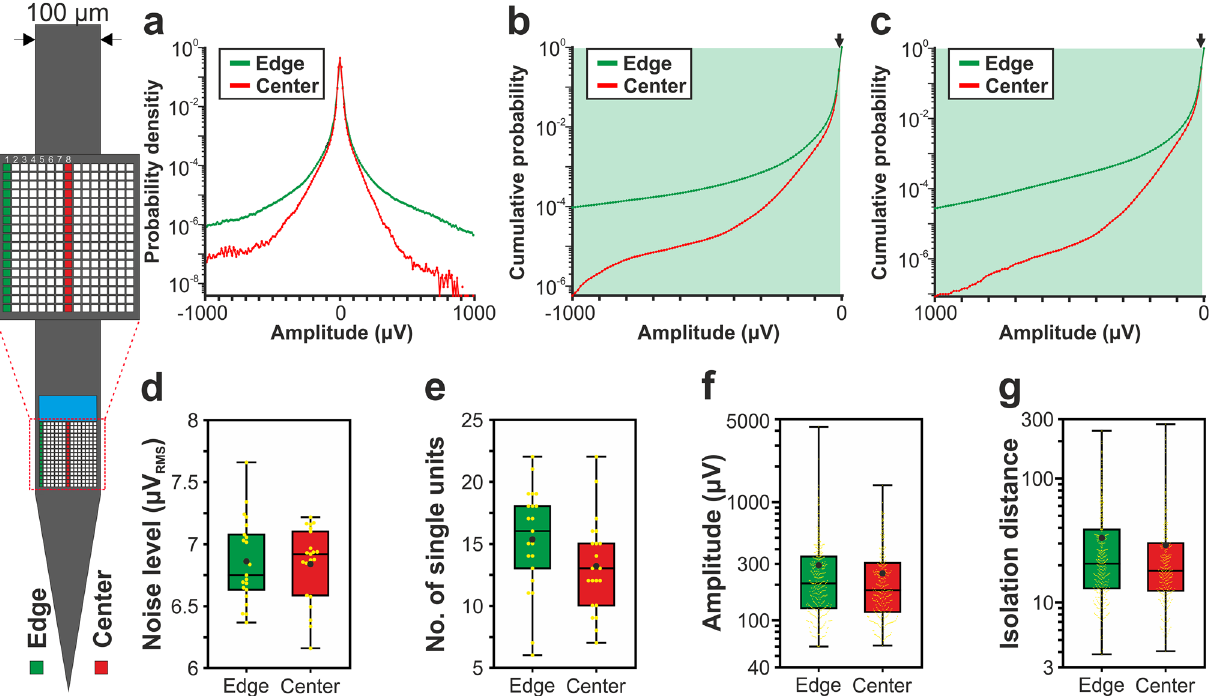
Figure 6. Comparison of the signal quality provided by edge (green) and center (red) sites of the 255-channel NeuroSeeker silicon probe. ( a ) Probability density functions estimated from the amplitude of samples recorded in the 500–5000 Hz frequency range (n = 21 recordings). Probability values lower than 10 –9 are not shown. ( b ) Cumulative distributions of amplitudes calculated in the negative amplitude range. ( c ) Reverse cumulative distributions calculated in the positive amplitude range. Green shaded areas in ( b ) and ( c ) indicate amplitudes with significantly higher numbers of edge samples. Arrows mark the maximal amplitude for edge significance in the negative range (− 10 µV; below this amplitude 14.45% of all negative samples were recorded on edge sites and 12.57% on center sites) and the minimal amplitude in the positive range (10 µV; above this amplitude 14.82% of all positive samples were recorded on edge sites and 12.63% on center sites). ( d ) Estimated in vivo noise level. ( e ) Single unit yield (n = 599). ( f ) Peak-to-peak amplitude of the averaged single unit spike waveforms. ( g ) Isolation distance of the single unit clusters. Note that most data are plotted on a logarithmic scale. Mann–Whitney U test was used in ( d – g